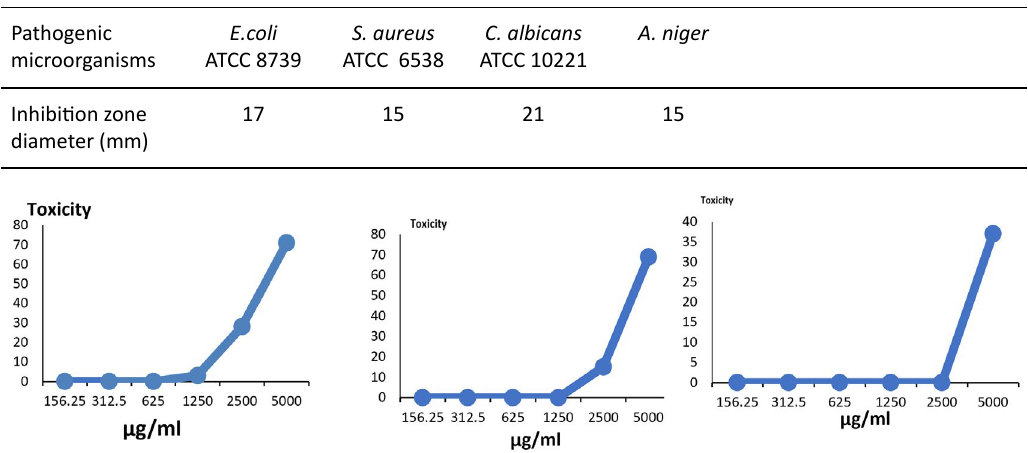
Fig. 7. Effect of different concentrations of ethyl acetate crude extract on HepG2 (A); HCT116 (B) and Mcf7 cell lines